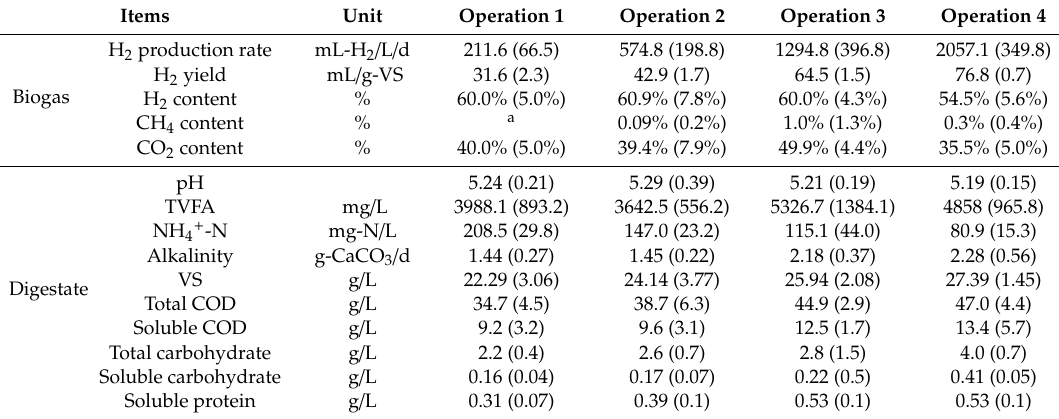
Table 3. The operational performances in H 2 -reactor at various hydraulic retention times (HRT) and organic loading rates (OLR).